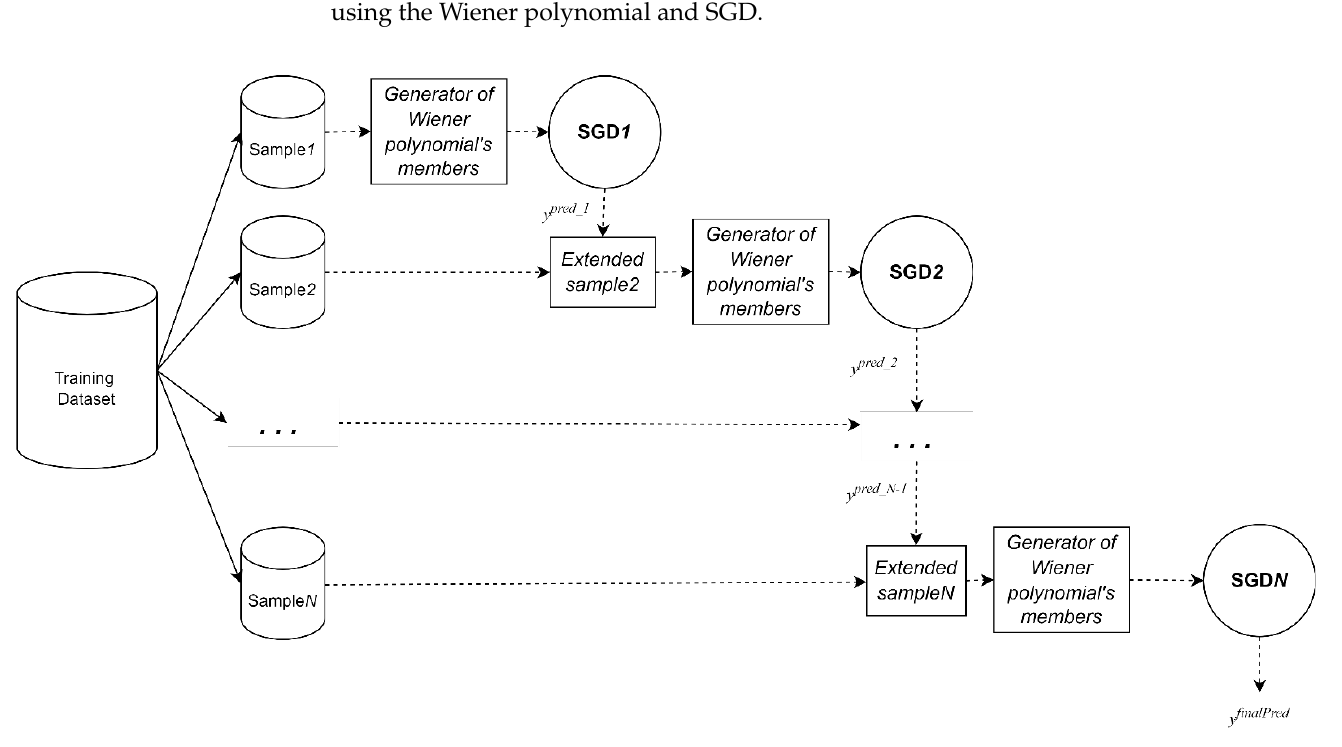
Figure 2. Architecture of the proposed ensemble scheme using Wiener polynomial and SGD: (train- ing mode).